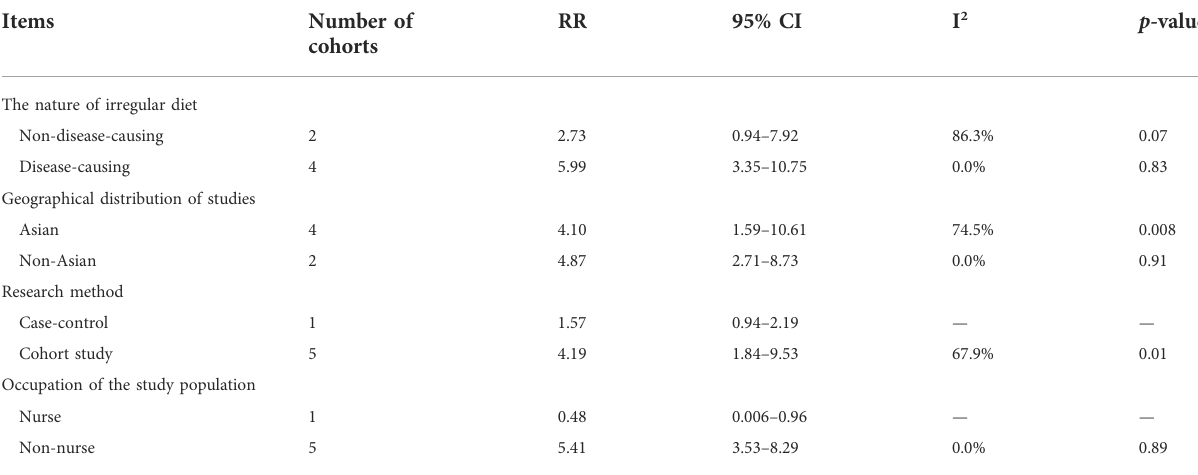
TABLE 3 Subgroup analysis of irregular diet and esophageal